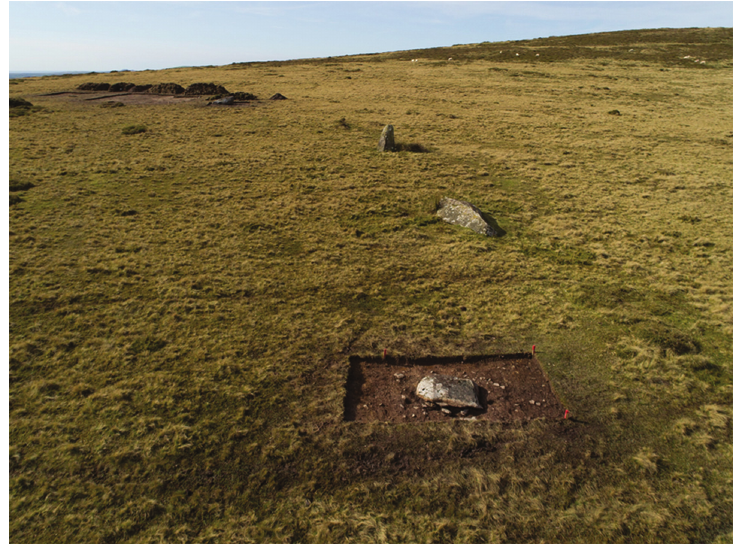
Figure 3 The arc of former standing stones at Waun Mawn during trial excavations in 2017, viewed from the east. Only one of them (third from the camera) is still standing. The stone in the foreground originally stood in a socket and formed one side of the solstice sunrise-oriented entrance of the former circle (Source: photograph by Adam